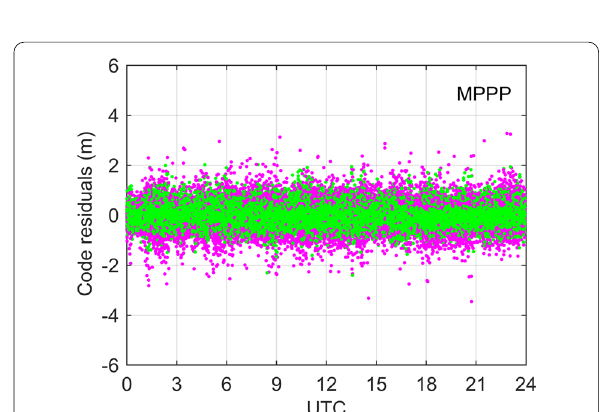
Fig. 6 P1 (magenta dots) and P2 (green dots) residuals of code observations at station MTDN using the MPPP